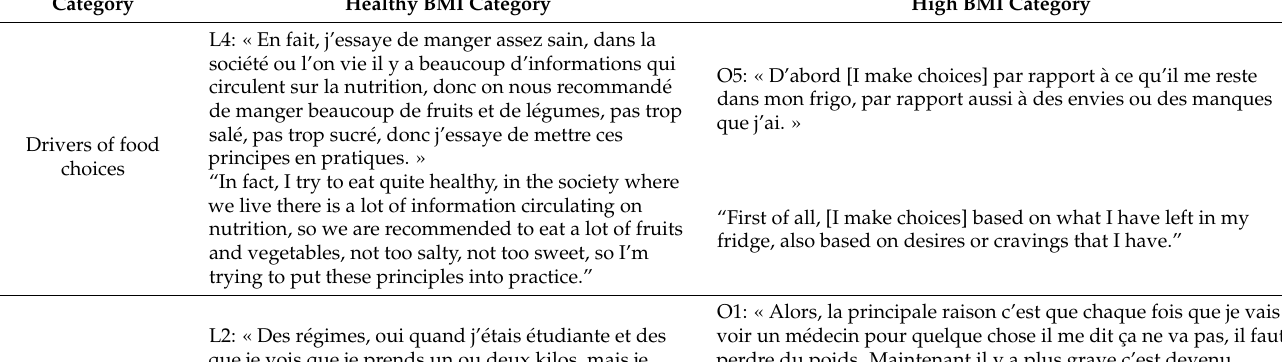
Table 4. Answer comparison by weight category in